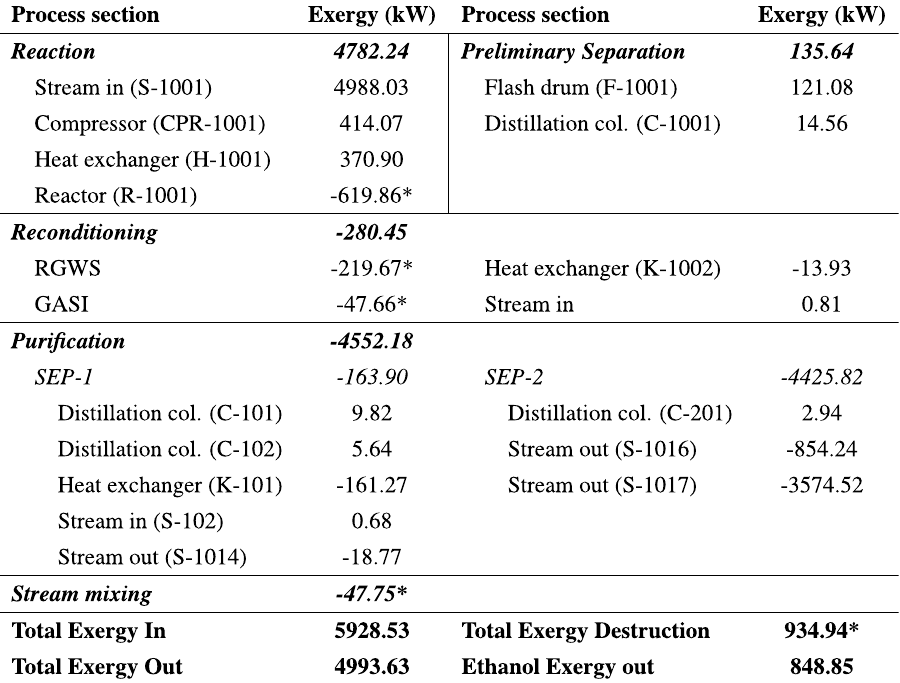
Table 1 Exergy quantification in each section of P-1